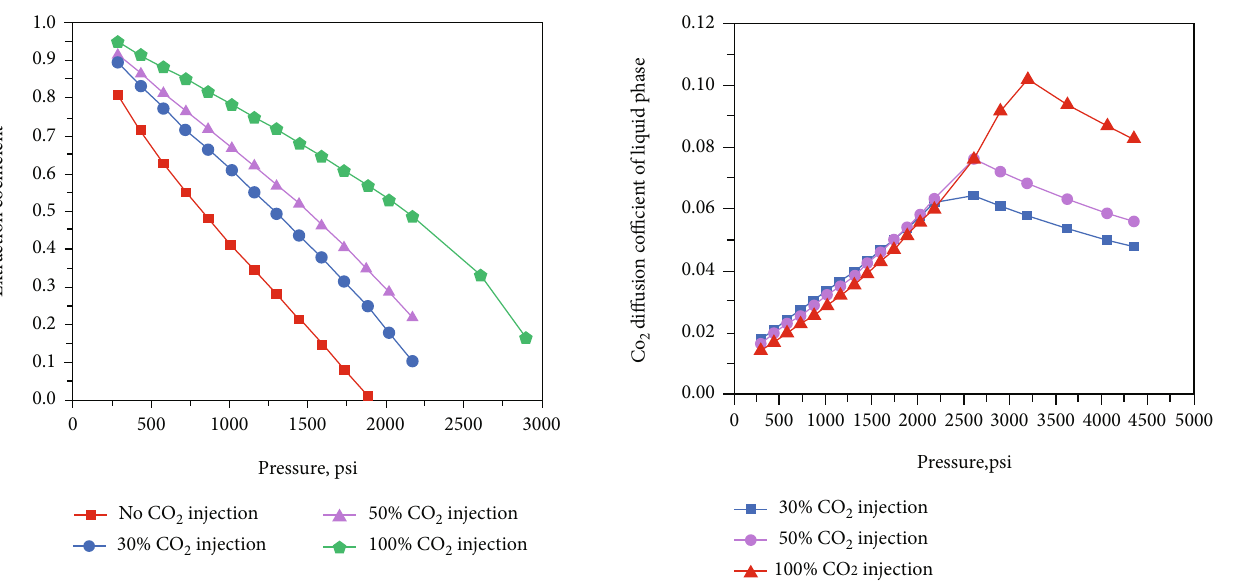
injections at T = 230 ° F. 2